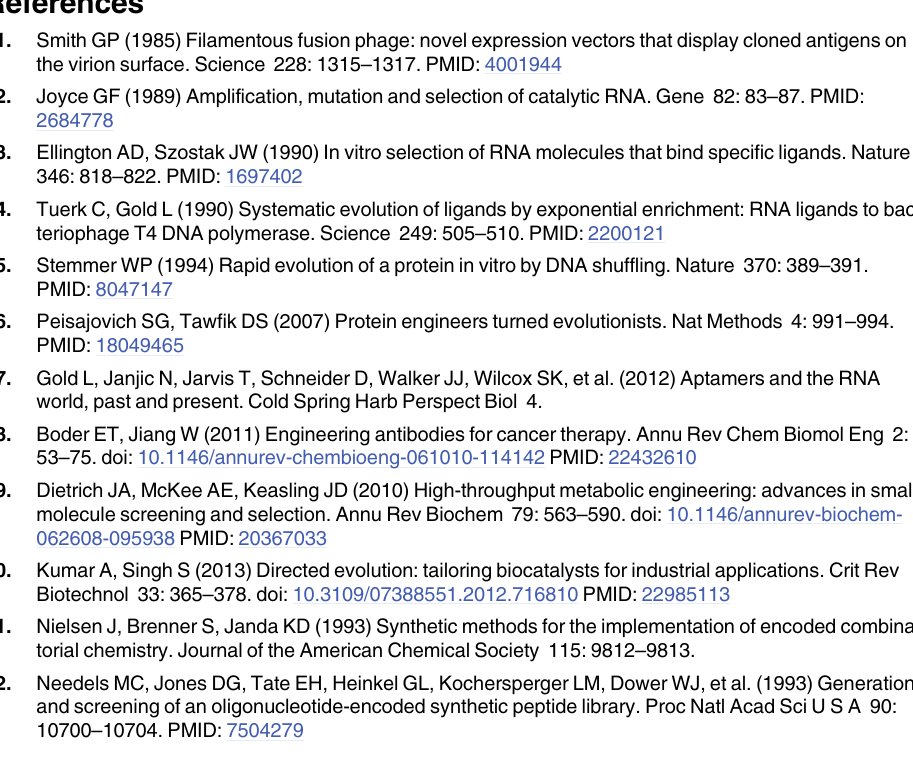
S4 Fig. (Related to Fig 4): Concordance of single-gene enrichment rank with true fitness rank. Values are shown for the 10829 genes with (cid:1) 10 reads. True fitness rank is the rank of the encoded peptide. The peptide ranks were determined by summing reads over all of the 1296 genes that encoded each peptide. More than 98% of the single genes encode a peptide product with a true fitness rank below 100. Twenty extreme outliers with spurious single-gene enrich- ments are evident. The corresponding peptide products all include two or more blank building